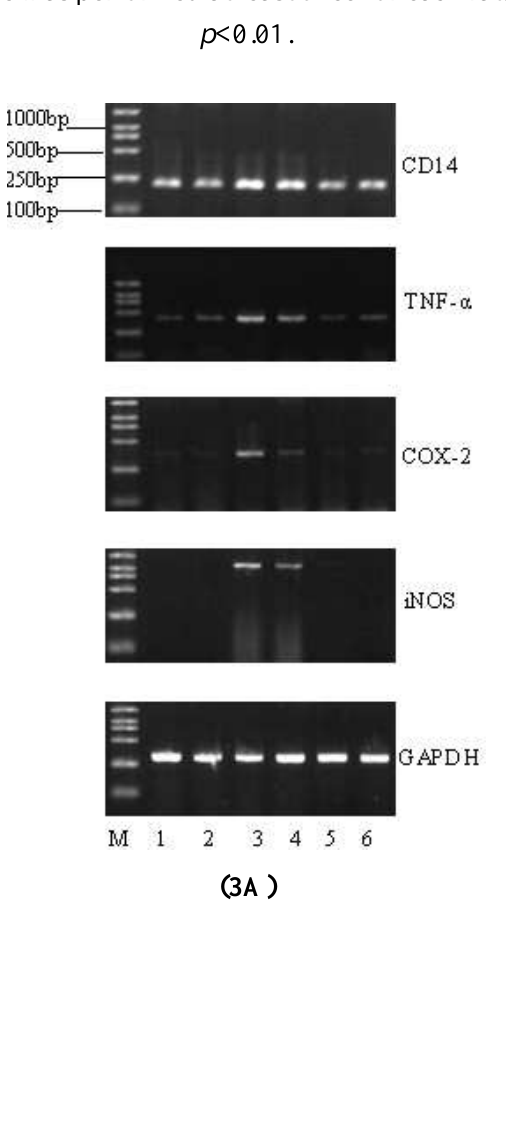
Figure3. RT-PCR analysis of mRNAs for CD14, TNF- α , COX-2, iNOS and GAPDH in liver samples obtained from the different groups: lane 1: D group, lane 2: D/E group, lane 3 and 4: A group, lane 5 and 6: A/E group (shown in A). The lanes represent different rats in each experimental group. Intense bands for CD14, TNF- α were observed in ethanol group, but in the other groups, only faint or weak bands were detected. COX-2 and iNOS mRNAs were detected only in fish oil plus ethanol-fed rats. None of the rats in the other groups had detectable COX-2 or iNOS mRNA. Shown in B are normalized densitometric ratios of CD14, TNF- α , COX-2 and iNOS bands to GAPDH respectively. RT-PCR analysis for each gene was performed at least once for each rat.* vs. D group, # vs. A group, p